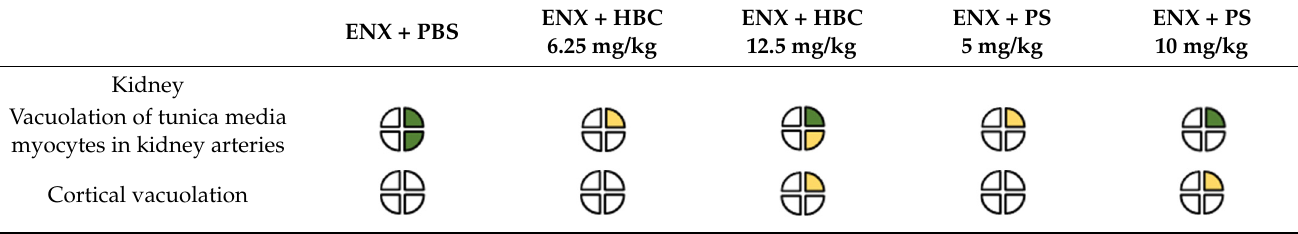
Table 1. Summary of histological changes in the kidney, lung, heart, liver, and spleen of mice treated subcutaneously with enoxaparin (ENX) (5 mg/kg) and an intravenous bolus of vehicle, HBC (6.25 and 12.5 mg/kg), or protamine sulfate (PS) (5 and 10 mg/kg). The organs were harvested 10 hours after antidote administration.